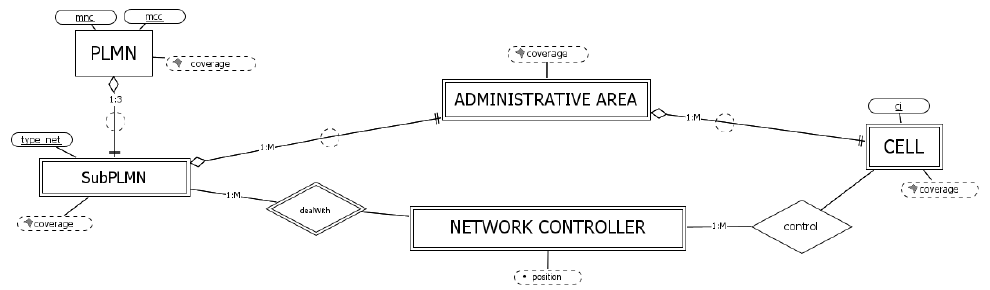
Figure 2. A high-level conceptual schema for cellular